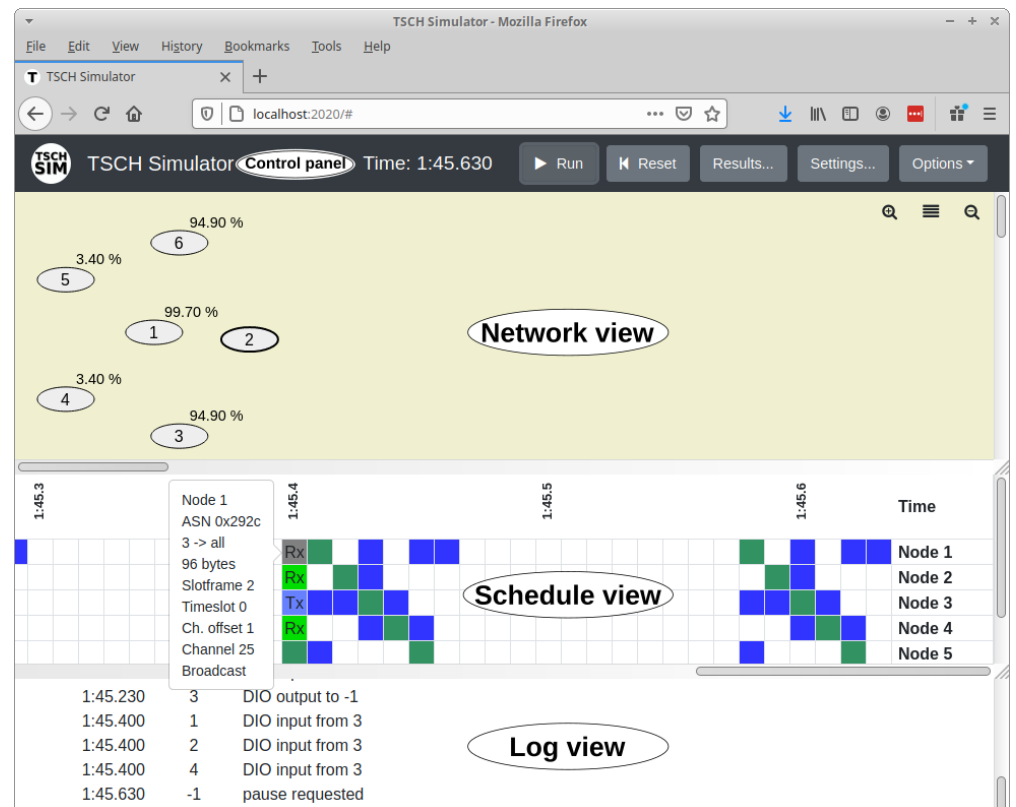
Figure 3. TSCH-Sim web